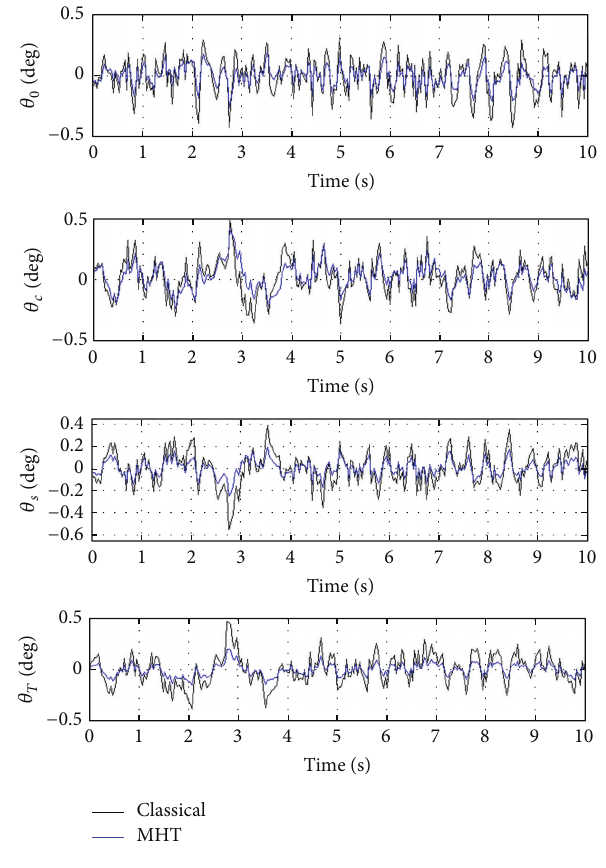
Figure 7: Responses of helicopter classical controls.